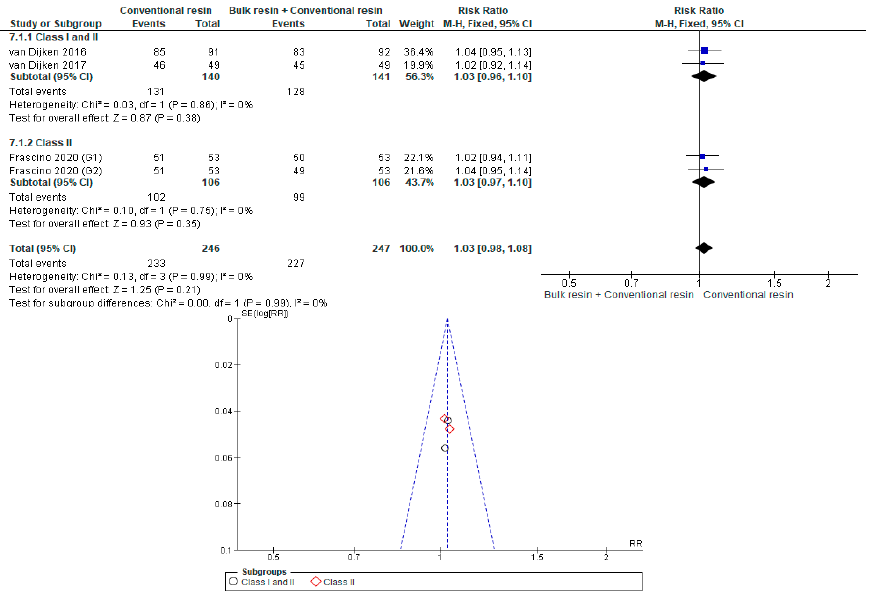
Figure A31. Proper Surface Texture: Conventional Resin versus Bulk Resin Covered with Conventional Resin According to Type of Restoration.